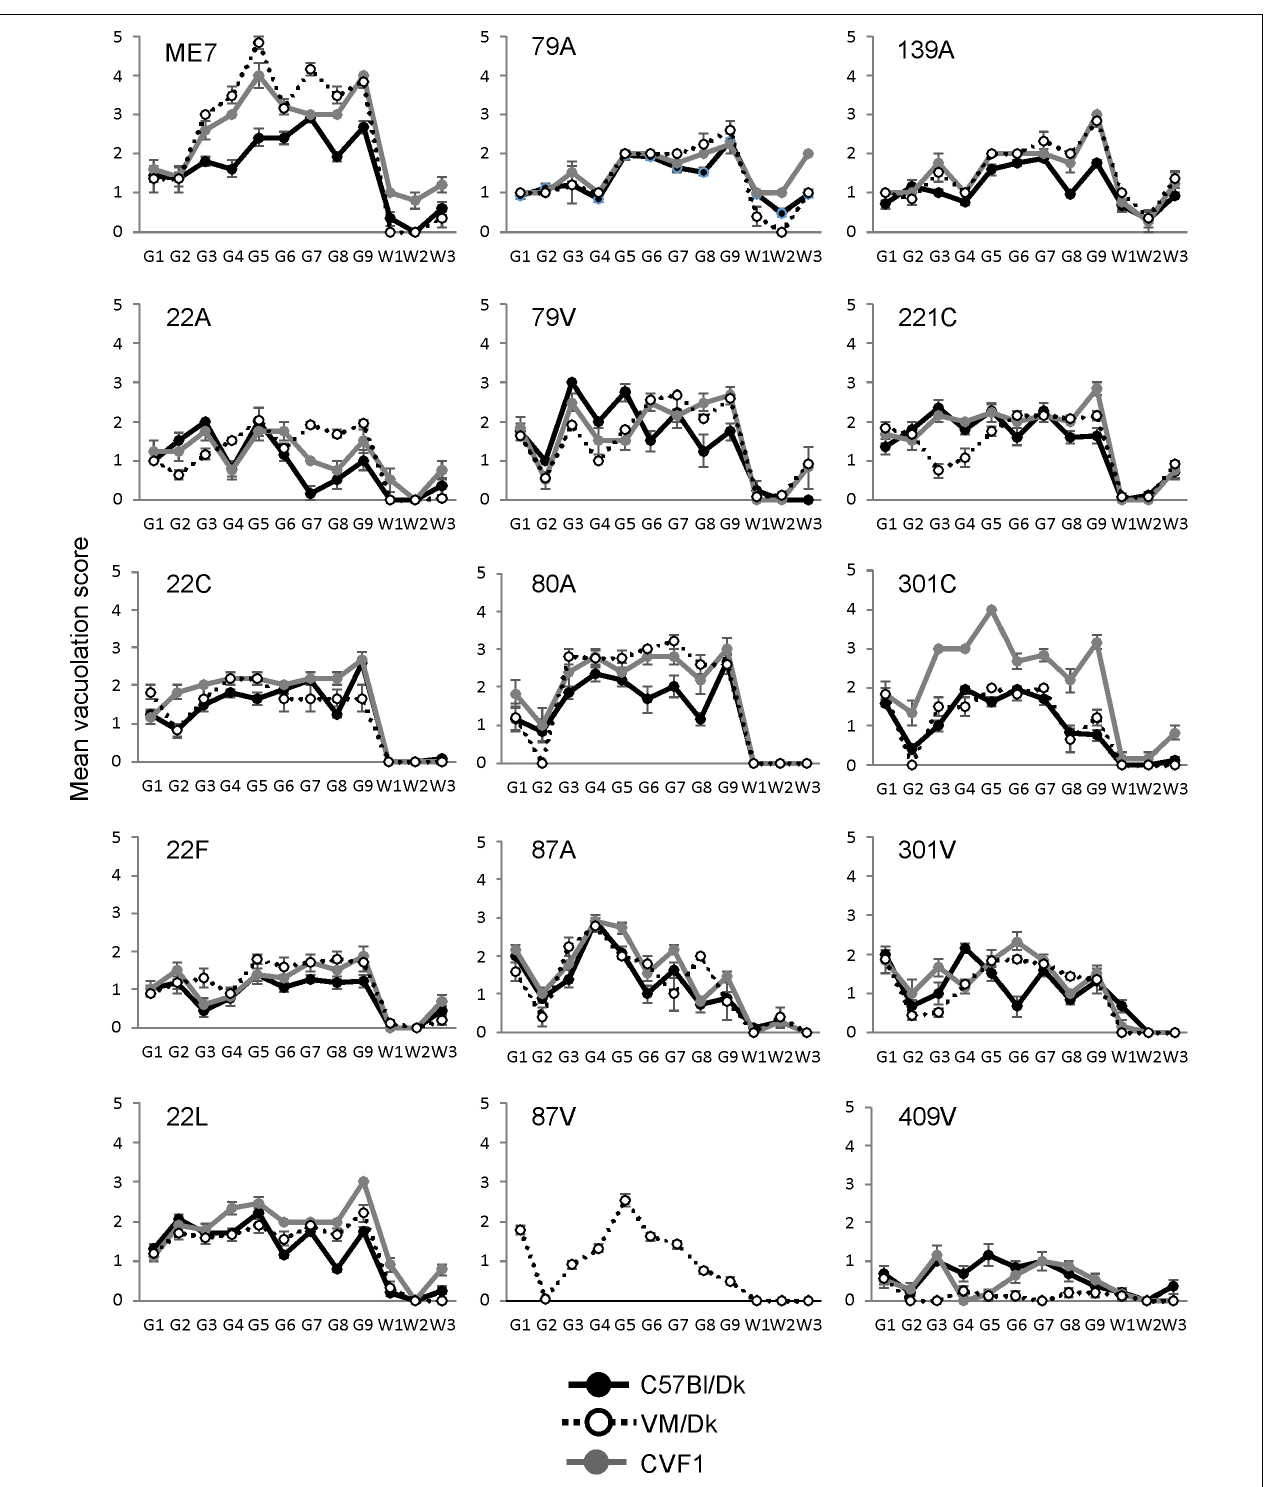
FIGURE 2 | Comparison of the magnitude and distribution of the spongiform pathology in the brains of mice infected with a variety of distinct prion agent strains. Groups of C57Bl/Dk or VM/Dk mice were injected intracerebrally with a variety of distinct prion agent strains ( Table 1 ). Brains were collected at the terminal stage of disease and the magnitude and distribution of the spongiform pathology (vacuolation) scored for each of the following brain regions G1, dorsal medulla; G2, cerebellar cortex; G3, superior colliculus; G4, hypothalamus; G5, medial thalamus; G6, hippocampus; G7, septum; G8, cerebral cortex; G9, forebrain cerebral cortex; W1, cerebellar white matter; W2, midbrain white matter; W3, cerebral peduncle. Data represent mean vacuolation severity scores ± SEM.